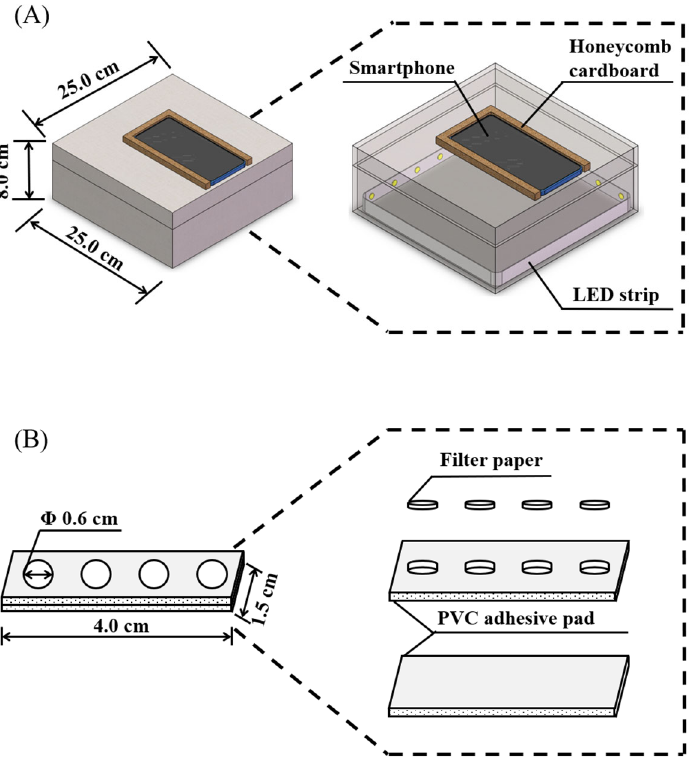
Figure 2. Structure diagram of homemade camera obscura ( A ) and paper ‐ based device ( B ).